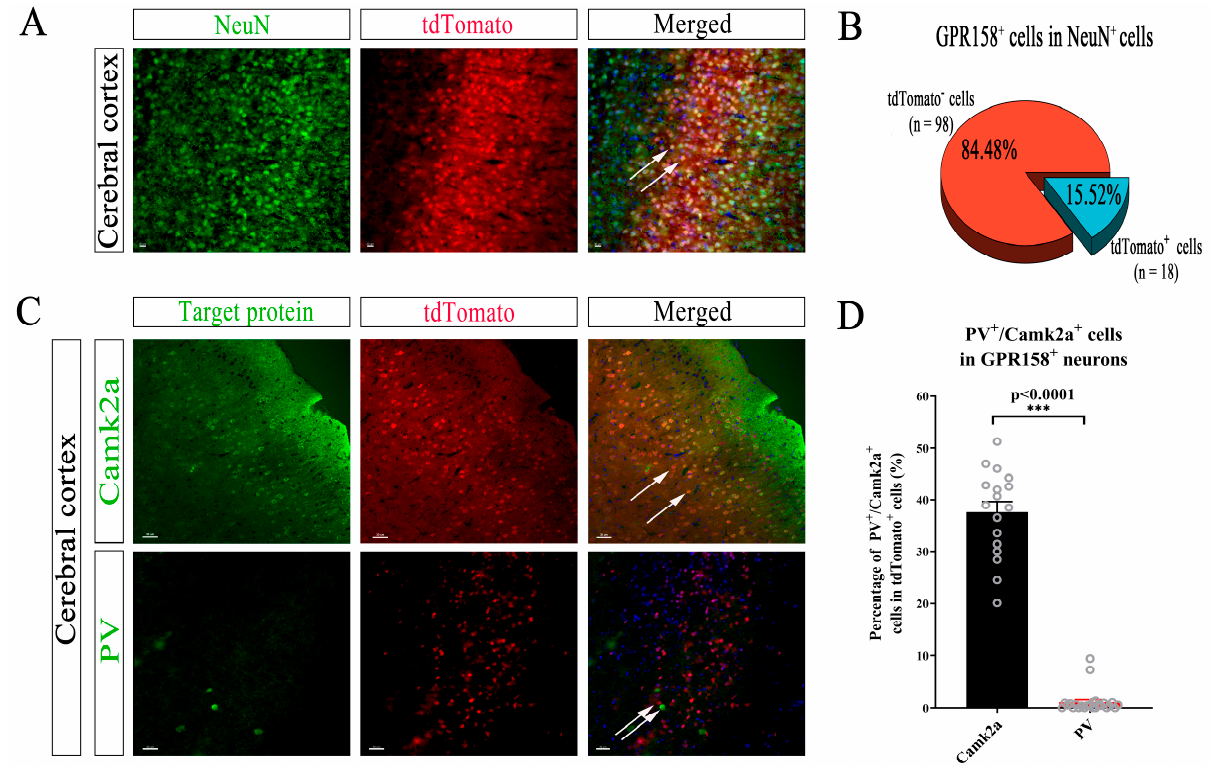
Figure 5. Cell types expressing tdTomato + neurons in the cerebral cortex of Gpr158 Tag mice at P60. ( A ) Immunofluorescence staining with an anti-NeuN antibody to label neurons and an anti-mCherry antibody to label tdTomato + cells expressing GPR158. ( B ) Percentage of tdTomato + cells among NeuN + cells in the cerebral cortex of Gpr158 Tag mice at P60 (12 slices from Gpr158 Tag mice ( n = 3, male)). ( C ) Immunofluorescence staining showing excitatory neurons labeled with an anti-Camk2a antibody and inhibitory neurons labeled with an anti-PV antibody, respectively. These cells were co-stained with tdTomato + neurons in layer 2/3 of the cerebral cortex of Gpr158 Tag mice.( D ) Percentage of double-positive cells (i.e., tdTomato + neurons co-stained with PV + or Camk2a + neurons) in total tdTomato + neurons in the cerebral cortex of Gpr158 Tag mice (PV + , 25 slices; Camk2a + , 17 slices from Gpr158 Tag mice ( n = 3, male, P60); ***, p < 0.0001). Scale bars, 30 μ m.